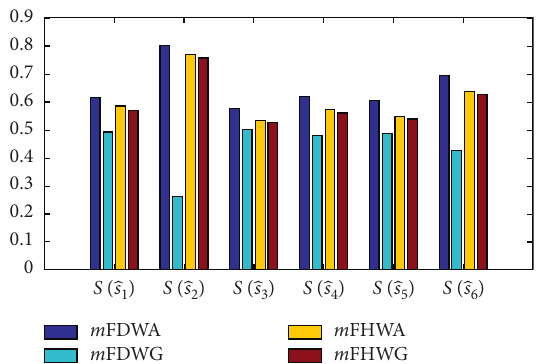
Figure 4: Comparison of second application in Section